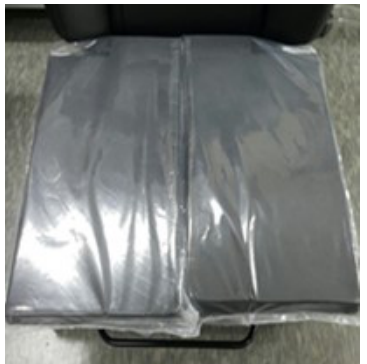
Figure 8. SSA seats equipped on test bed.